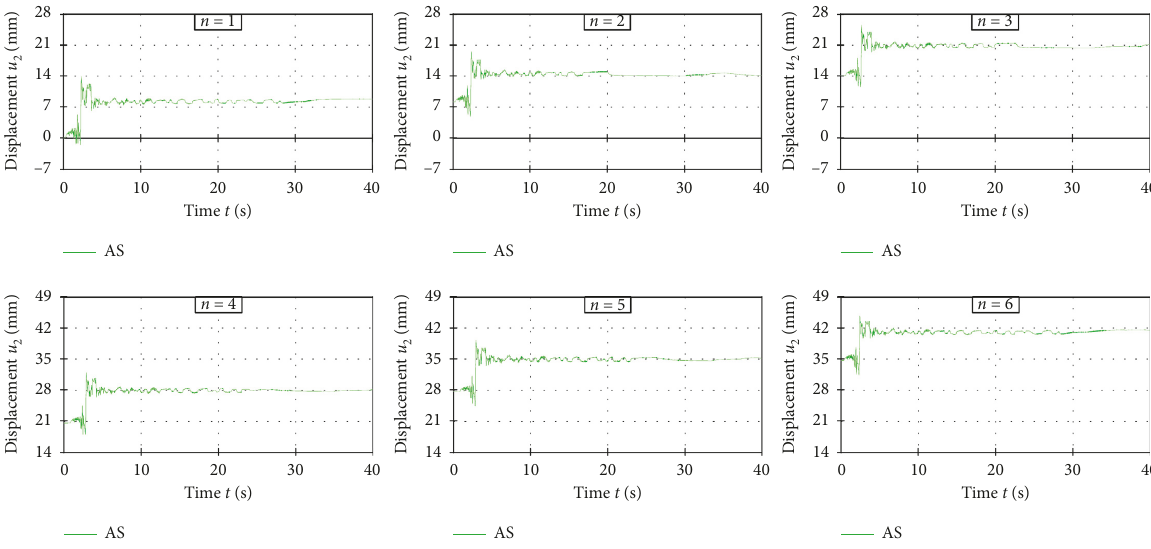
Figure 28: Horizontal displacement u